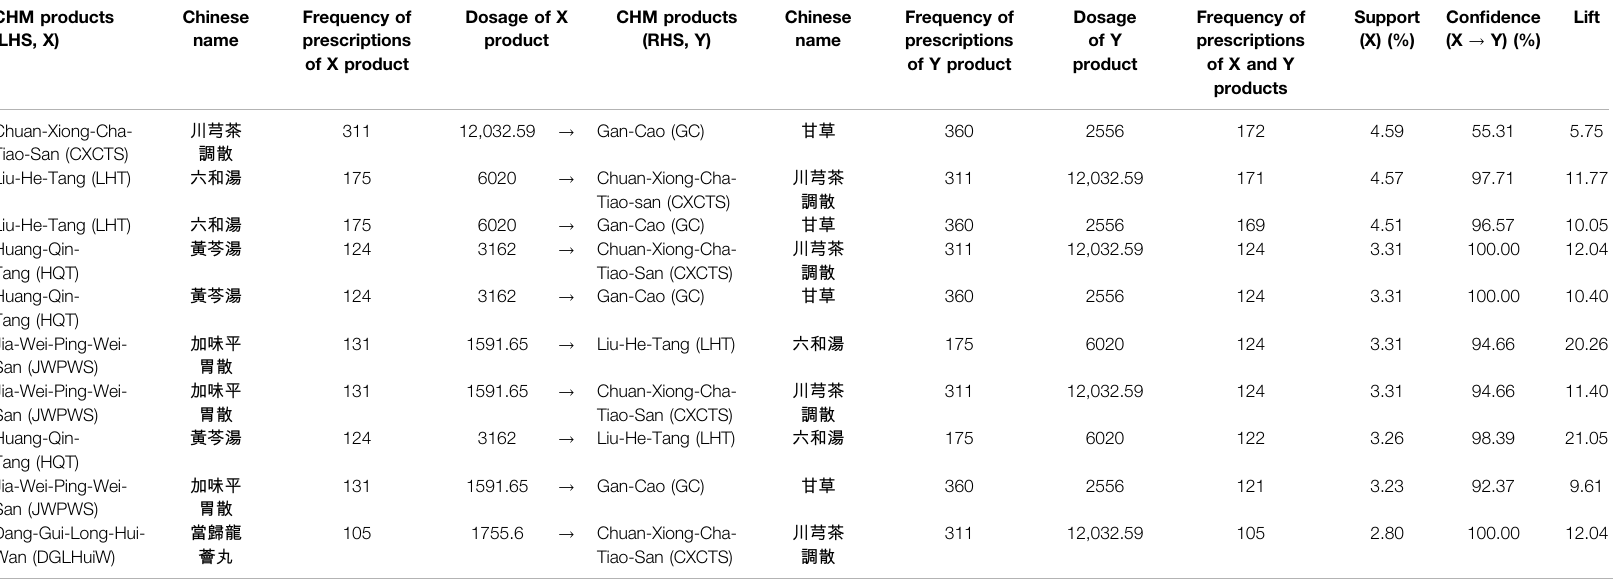
TABLE 3 | Ten most commonly used co-prescriptions of CHM products for HIV-infected patients with osteoporosis or fractures in Taiwan. CHM products (LHS,